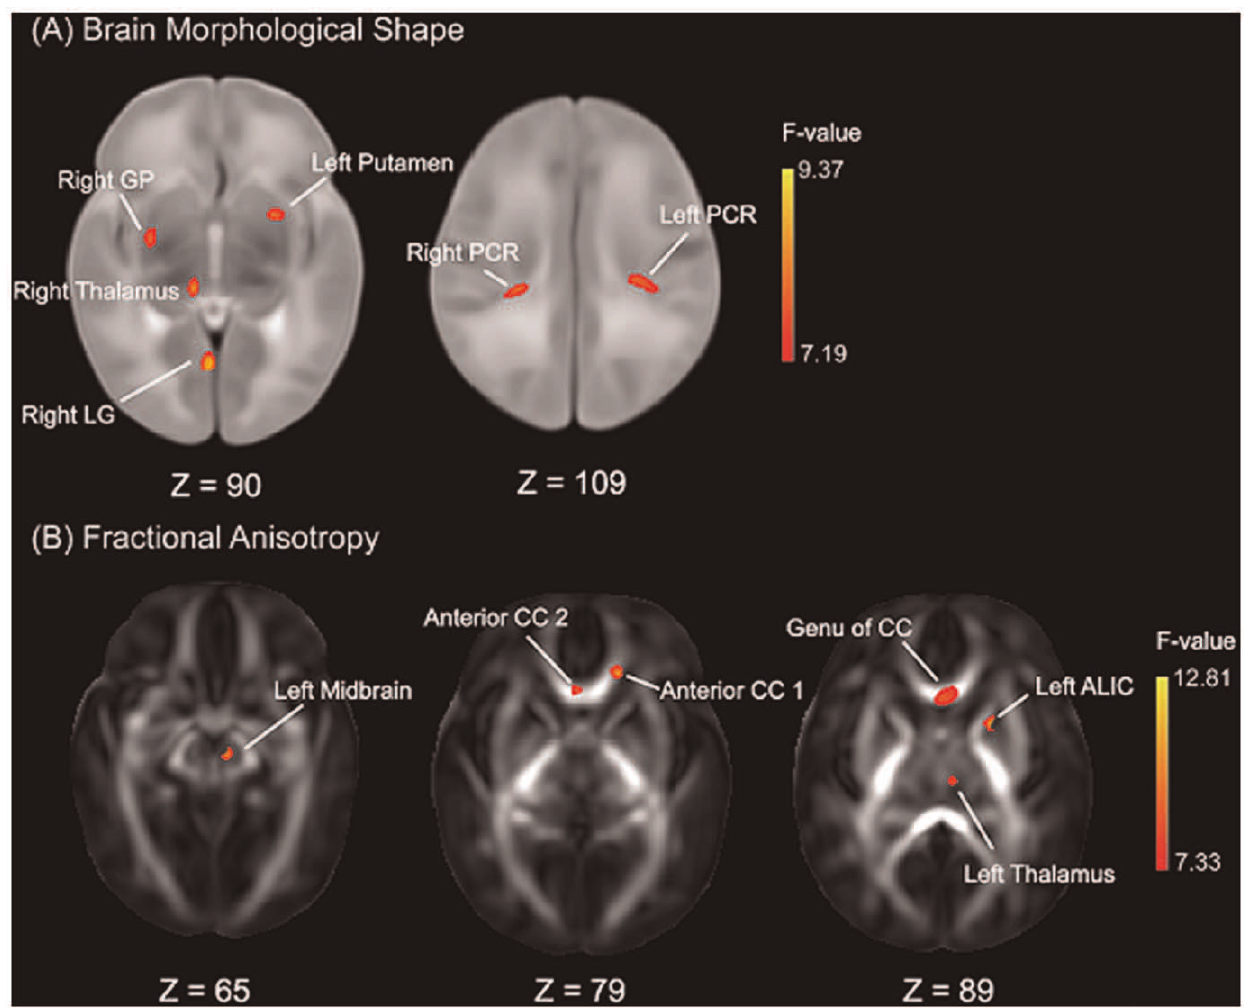
Figure 2. Statistical Maps of ethnic group difference in brain morphological shape (A) and fractional anisotropy (B). The anatomical coordinates of each axial slice are given at the bottom of each panel. Abbreviations: LG – lingual gyrus; PCR – posterior corona radiata; GP – globus pallidus; ALIC – anterior limb of internal capsule; CC – corpus callosum. doi:10.1371/journal.pone.0047816.g002 PLOS ONE |